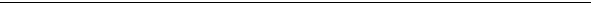
Table 1 | Fitted power-law correlation results and the coef fi - cient of determination, R 2 , of the subsets of data points (Fig. 3), using orthogonal distance regression (see ‘ Methods ’ ) Flow type Figure Curve fi t R 2